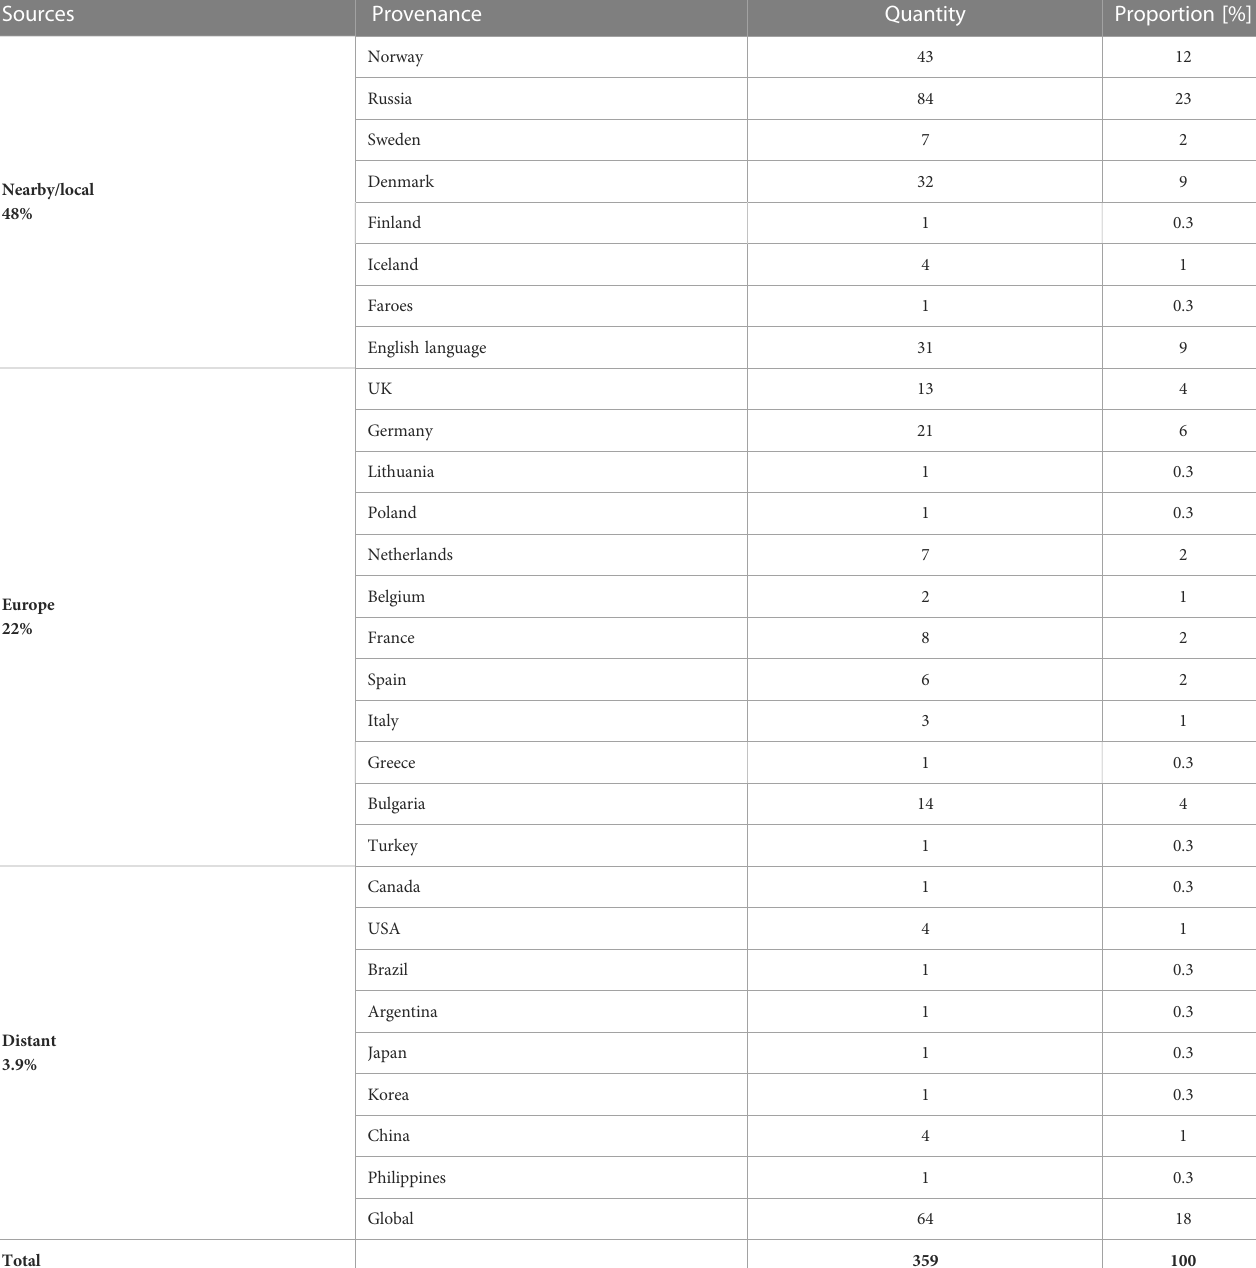
TABLE 5 Summary of provenance identi fi ed (three big packs pooled) in order of proximity to Svalbard categorized into source regions.